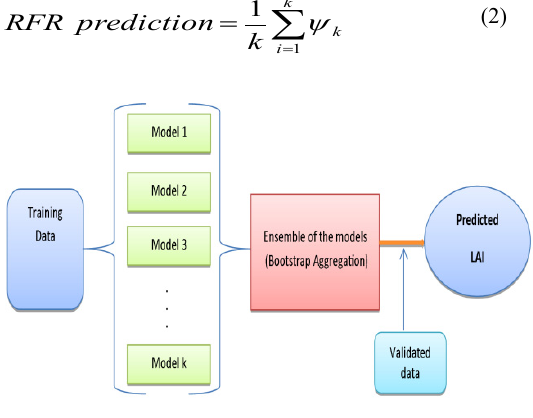
Figure 2.RFR algorithms architecture for LAI